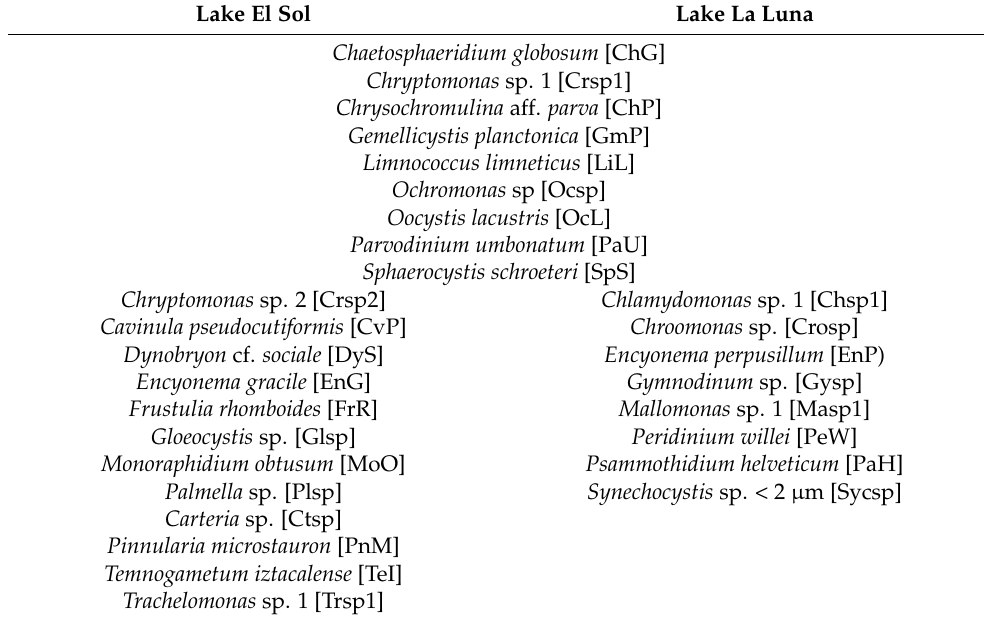
Table 3. Representative species (large abundance and high frequency of occurrence) in Lakes El Sol and La Luna.